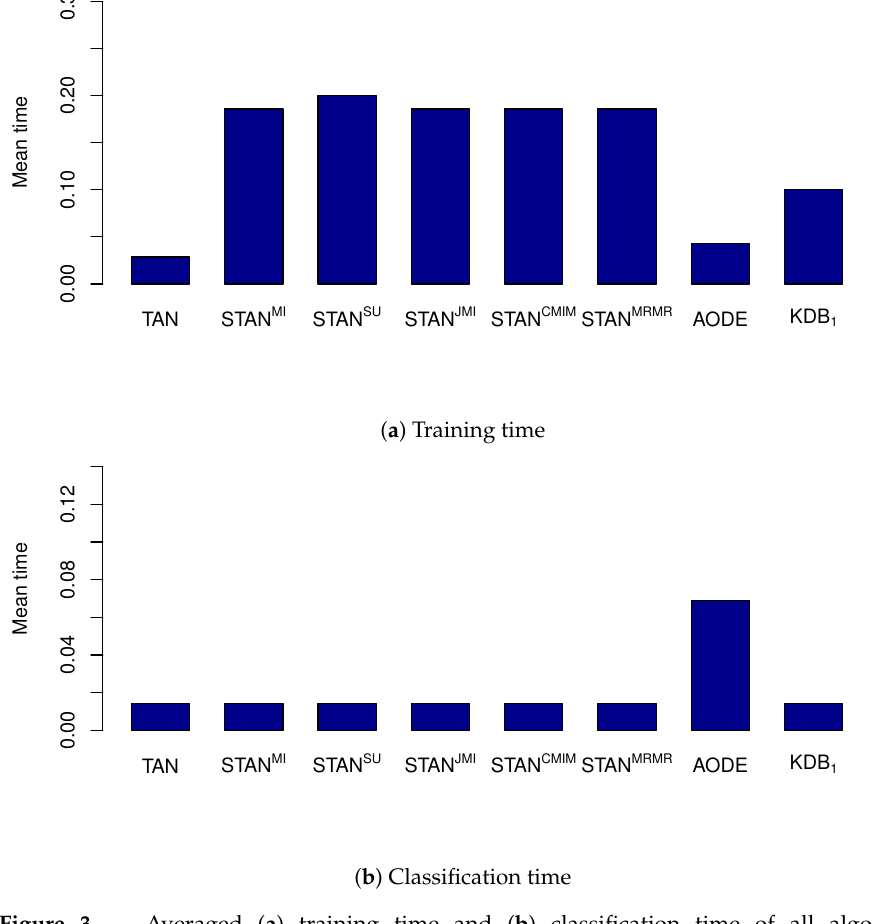
Figure 3. Averaged ( a ) training time and ( b ) classification time of all algorithms on 70 datasets